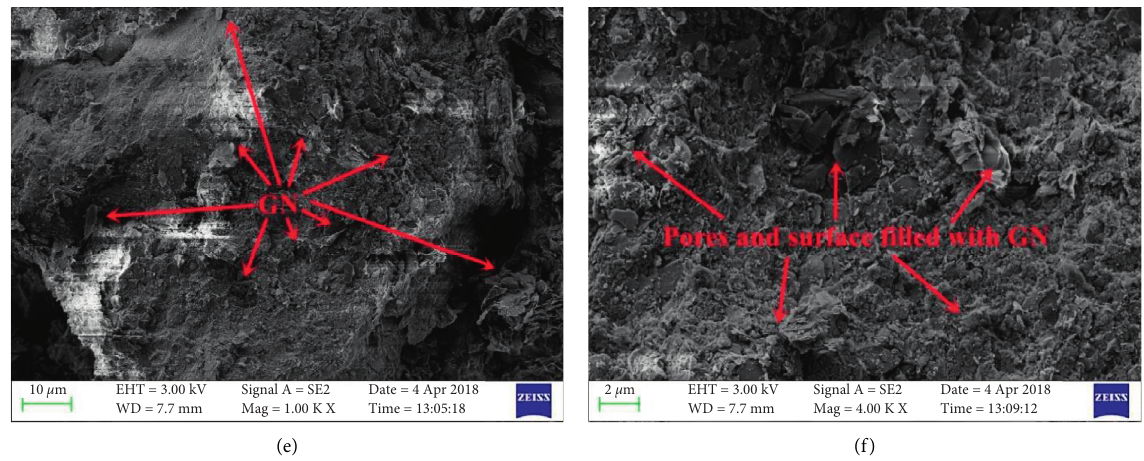
Figure 17: SEM of laterite and GN-laterite, (a) ρ M � 0%, 1 000 × , (d) ρ d � 1.50g/cm 3 , M � 0%, 4 000 × , (e) ρ d � 1.40g/cm 3 , M � 1.0%, 1 000 × , and (f) ρ d � 1.40 g/cm 3 , M � 1.0%, 4 000 ×